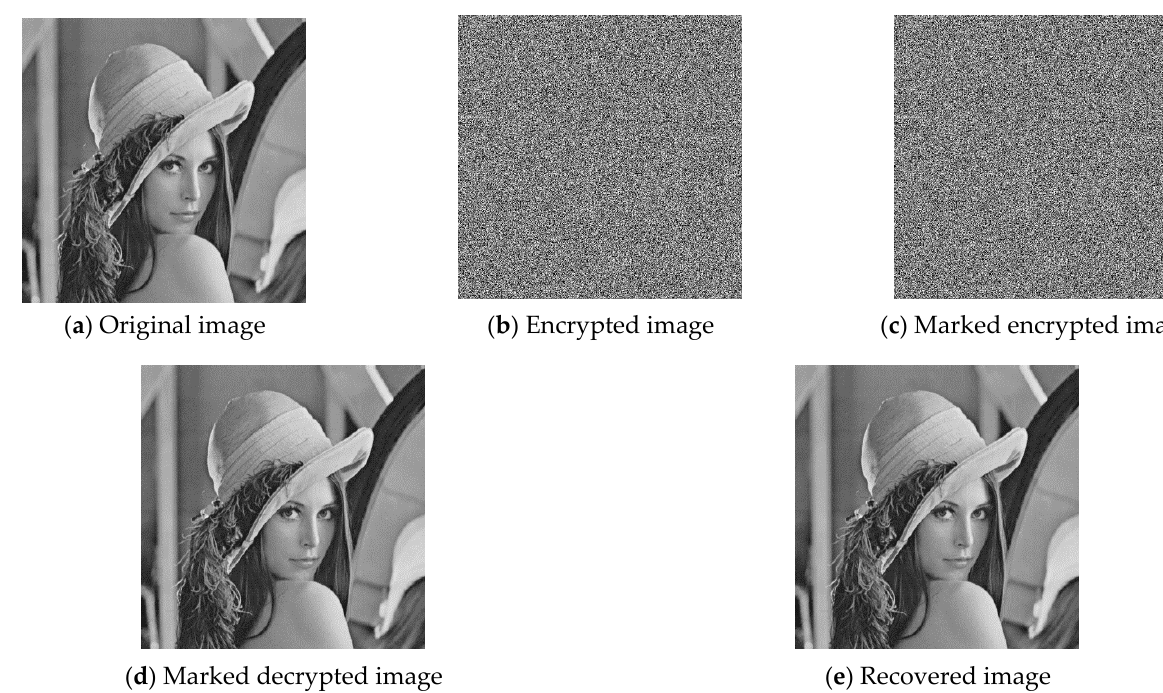
Figure 7. Experimental images of Lena in the proposed method. Table 1. Comparison of embedding rates for the eight test images. Images